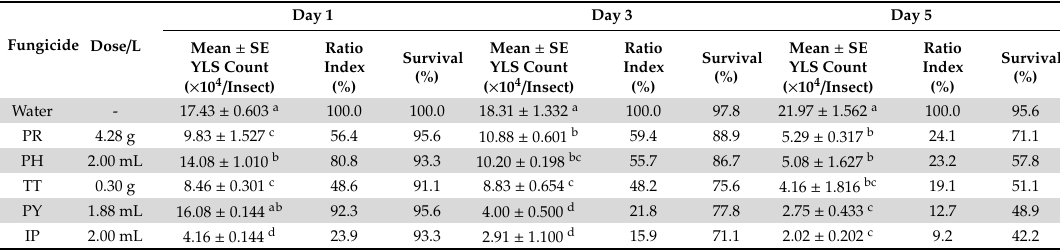
a–d : Di ff erent letters denote significant di ff erences in values among treatments in the same column and same day ( p < 0.05).